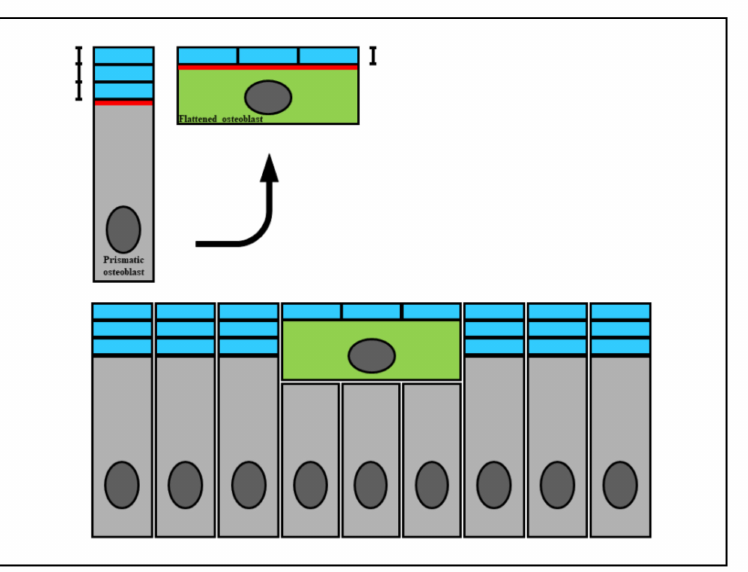
Figure 1. A diagram showing how the wideness of osteoblast secretory territory (red line) varies during its recruitment (green osteoblast), since the produced osteoid seam (blue bars) stratifies on a larger surface according to the morphological modification from a prismatic to a flattened shape. This fact explains the incorporation of recruited osteoblasts transforming into osteocytes (see text for